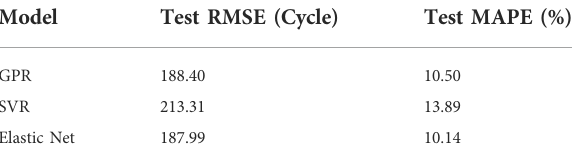
TABLE 1 Metric for different regression